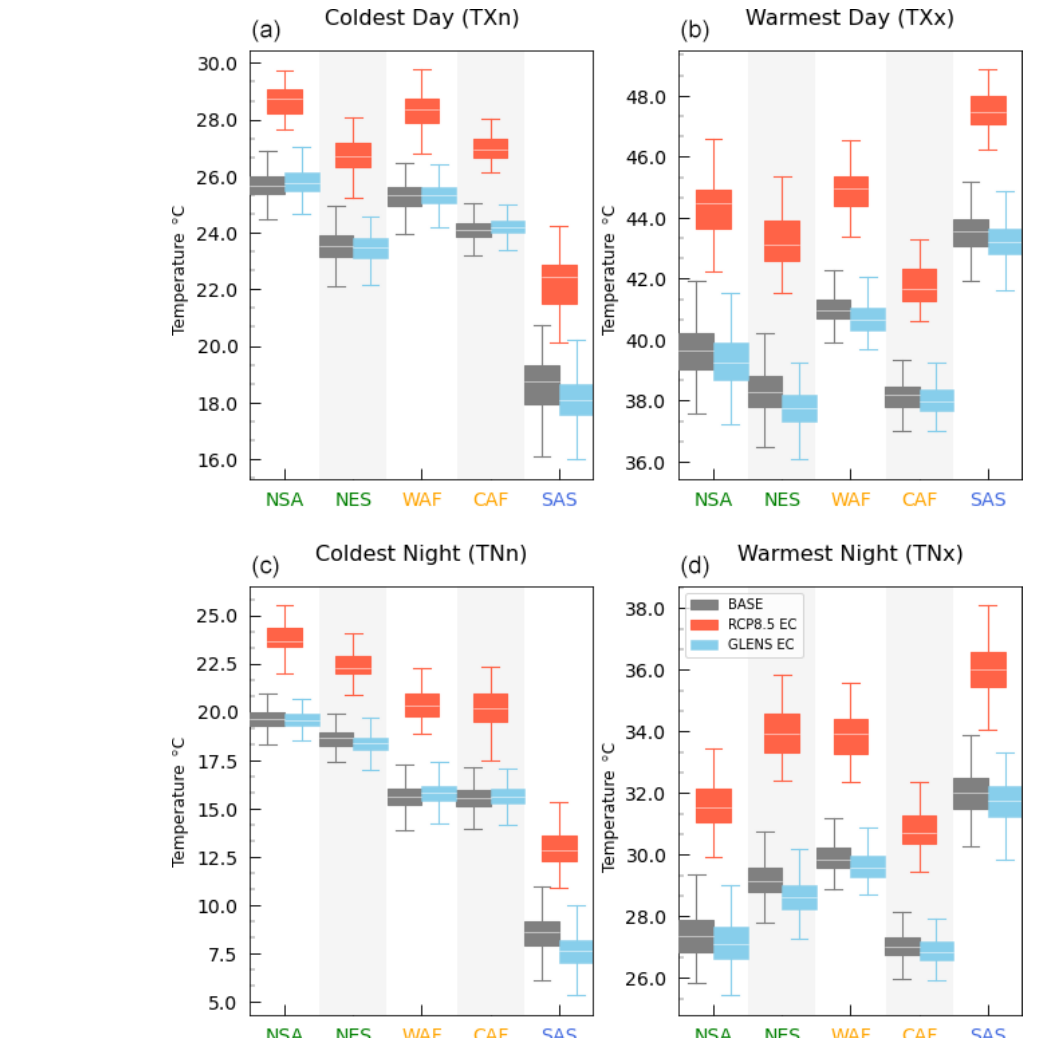
Figure 12. Regional box plots indicating the ensemble ranges of temperature indices for BASE (2010–2030; gray boxes), RCP8.5 EC (2075–2095; red boxes), and GLENS EC (2075–2095; blue boxes) for the annual minimum daily maximum (coldest day, TXn, a ), annual maximum daily maximum (warmest day, TXx, b ), annual minimum daily minimum (coldest night, TNn, c ), and annual maximum daily minimum (warmest night, TNx, d ) for northern South America (NSA), northeastern South America (NES), western Africa (WAF), central Africa (CAF), and South Asia